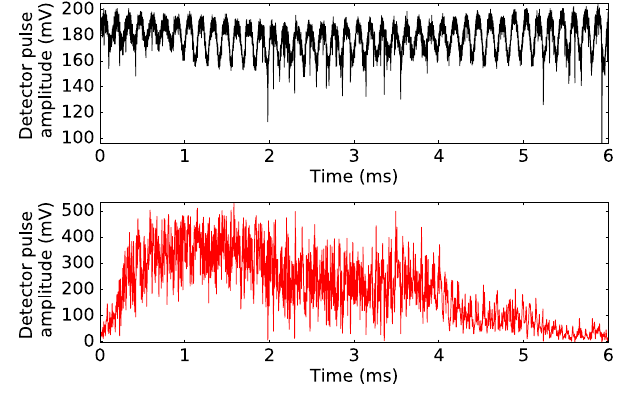
FIG. 4. Data recorded by KAPTURE using two different detectors in parallel. The top panel shows the signal from an APD in the visible range while the bottom panel shows the turn- by-turn THz signal recorded using a narrow-band Schottky detector [29]. The THz signal has the sawtooth-like pattern induced by the bursting and the APD signal is modulated by the synchrotron